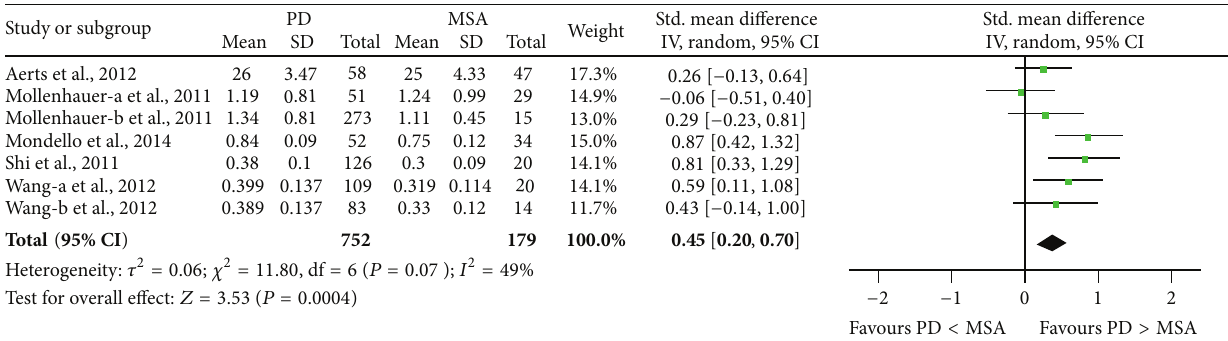
Figure 4: Forest plot of CSF 𝛼 -syn levels in PD compared to